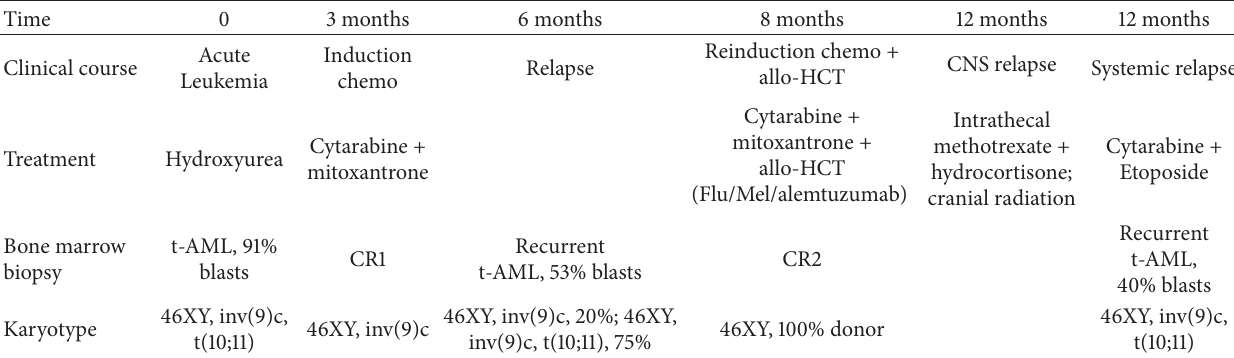
Table 1: Clinical course and cytogenetic abnormalities of the patient.